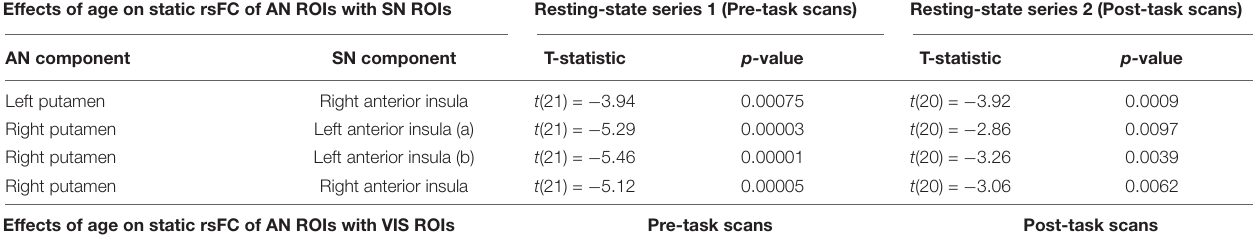
TABLE 2 | Significant effects of Age in predicting static rsFC between ROIs, grouped by